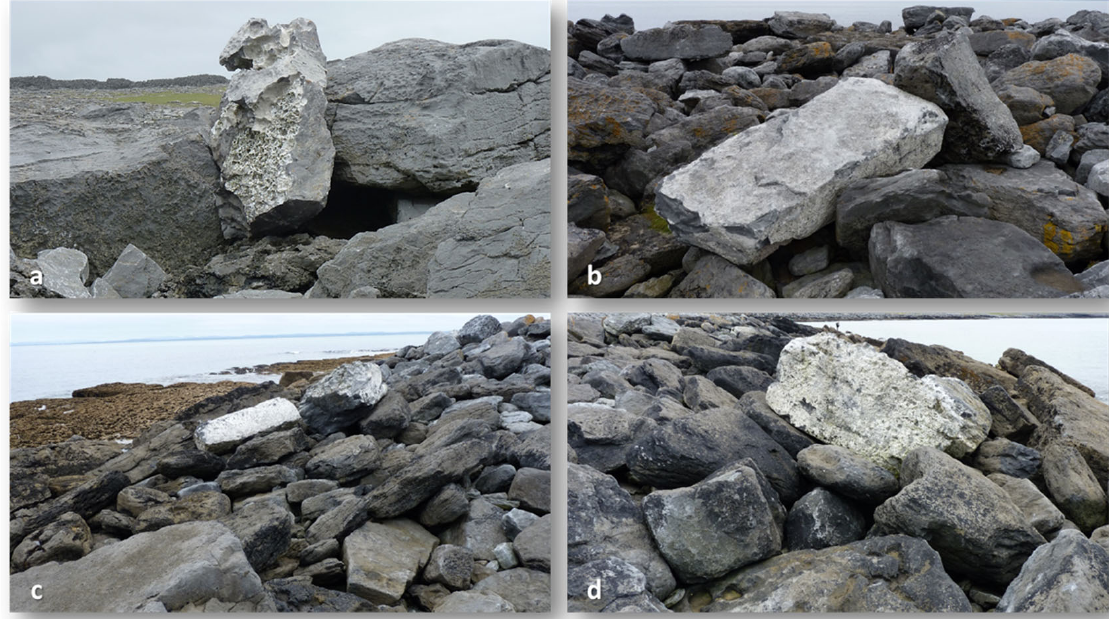
Figure 8. Individual boulders from the tidal belt up to several tons in mass, covered by calcareous algae and balanids (all examples ( a – d ) from the coastal section inside Galway Bay, SE coast).